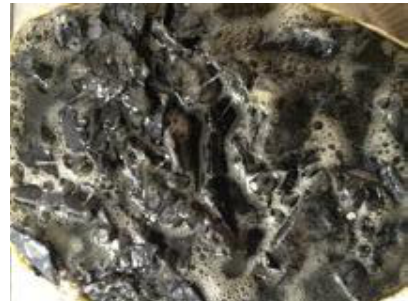
Figure 5. Photo of gangue solidification using a high-polymer material.